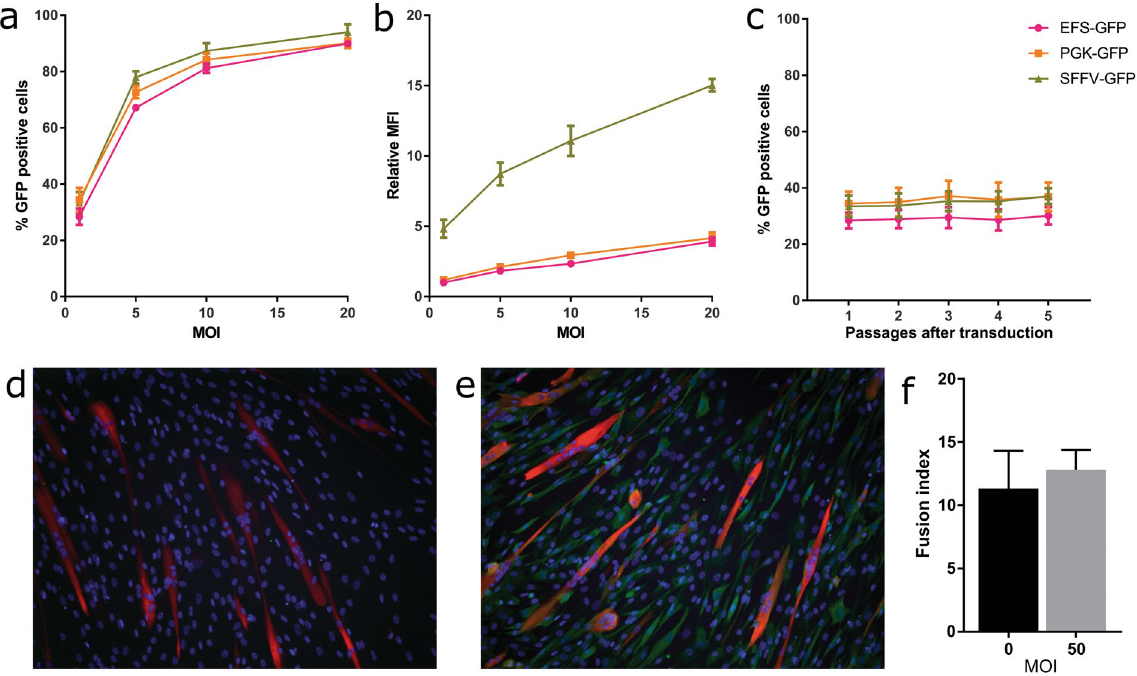
Figure 3. FVV transduction efficiency, promoter activity and toxicity in muscle derived cells. ( a – c ) FVVs carrying an EFS, PGK or SFFV promoter to drive constitutive GFP expression were added at various MOIs to muscle derived cells (cell line 1). The percent of cells expressing GFP ( a ) and their median fluorescence intensity ( b ) was determined by flow cytometry 1 passage post-transduction. ( c ) The percent of cells expressing GFP following each passage up to 5 post-transduction using an MOI of 1 was determined to analyse stability of expression. ( d , e ) Immunofluorescence staining of muscle derived cells (cell line 2) following culture in differentiation medium with antibodies targeting the myosin heavy chain (red). GFP is shown in green and DAPI-stained nuclei in blue. Panel d was untransduced, panel e was transduced at a MOI of 50 with DF-EFS- GFP-WPRE. The number of myotubes staining positive for myosin heavy chain were counted in 5 randomly selected fields-of-view to give the fusion index ( f ). Bars show mean +